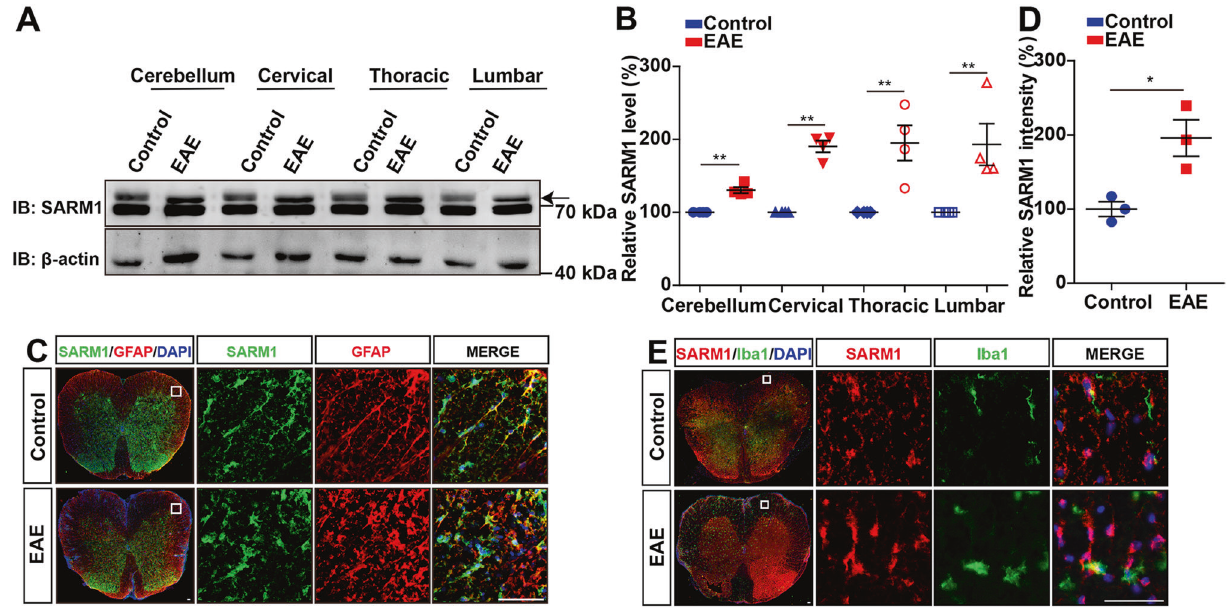
Fig. 1 SARM1 was upregulated in astrocytes of spinal cords of EAE mice. A Western blot analysis of SARM1 expression in the cerebellum, cervical, thoracic and lumbar spinal cords of control and EAE mice. The higher molecular weight band is marked with an arrow as the band corresponding to SARM1. B Quantitative analysis of the relative SARM1 levels as shown in A (normalized to control mice, n = 4). C Double immunostaining analysis of SARM1 (green) and GFAP (red) in control and EAE mice. D Quantitative analysis of intensity of SARM1 C ( n = 3). E Double immunostaining analysis of SARM1 (red) and Iba1 (green) in the spinal cords of control mice and EAE mice. Scale bar, 50 μ m. Data were mean ± SEM. Student ’ s t-test, * p < 0.05, ** p <